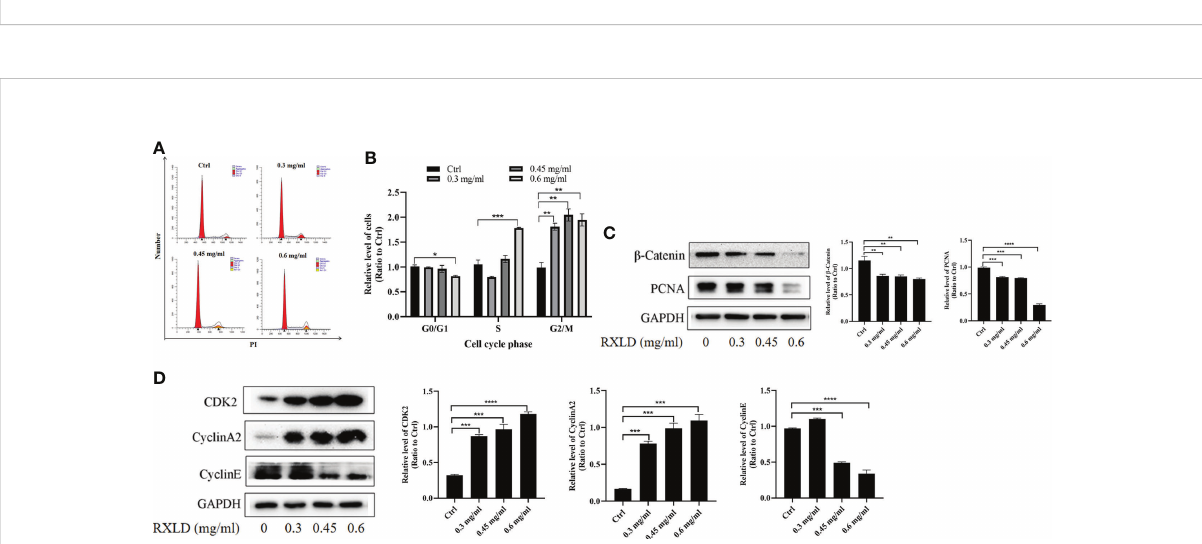
FIGURE 8 RXLD extracts blocked the GBM cell cycle in the G2/M and the S phases, and can inhibit the Wnt/ b -catenin pathway. (A, B) Cell cycle analysis of the A172 cells treated with RXLD extracts (0.3, 0.45, and 0.6 mg/ml) for 48 h, with DNA fragmentation being observed; (C, D) Western blotting results of cell cycle-related genes ( b -catenin, PCNA, cyclin E, CDK2, and cyclin A2) expressed in A172 cells that were treated with RXLD extracts (0.3, 0.45, and 0.6 mg/ml) for 48 h. * P<0.05, ** P<0.01, *** P< 0.001, ****